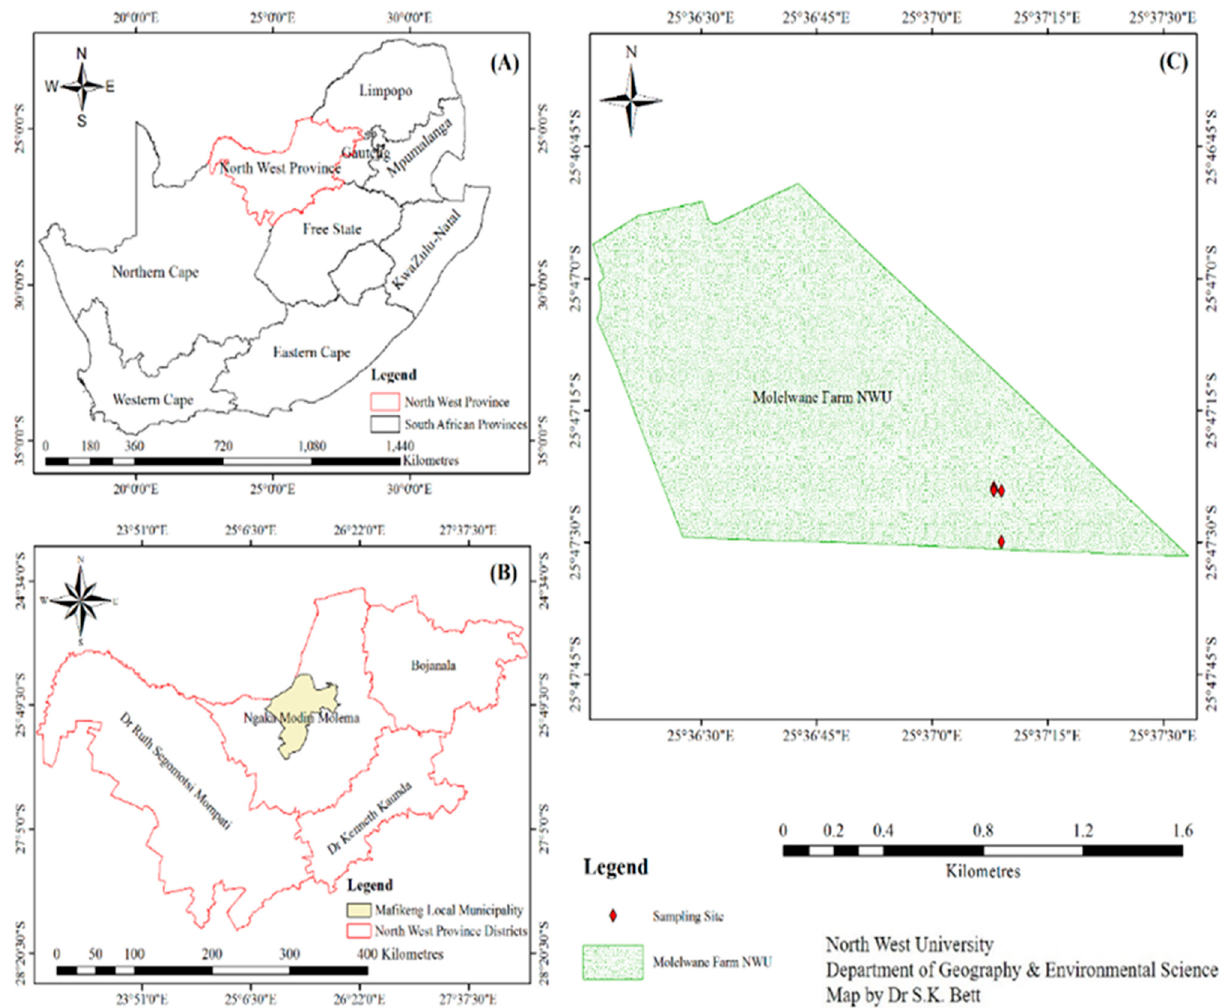
Figure 1. Sketch map of the study area, Molelwane farm, North West Province, South Africa. ( A ) North west province, ( B ) Mafikeng local municipality, ( C ) Molelwane farm.